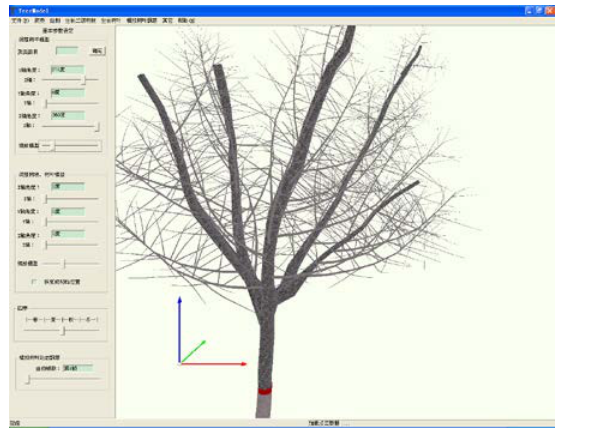
Figure 3. Final tree